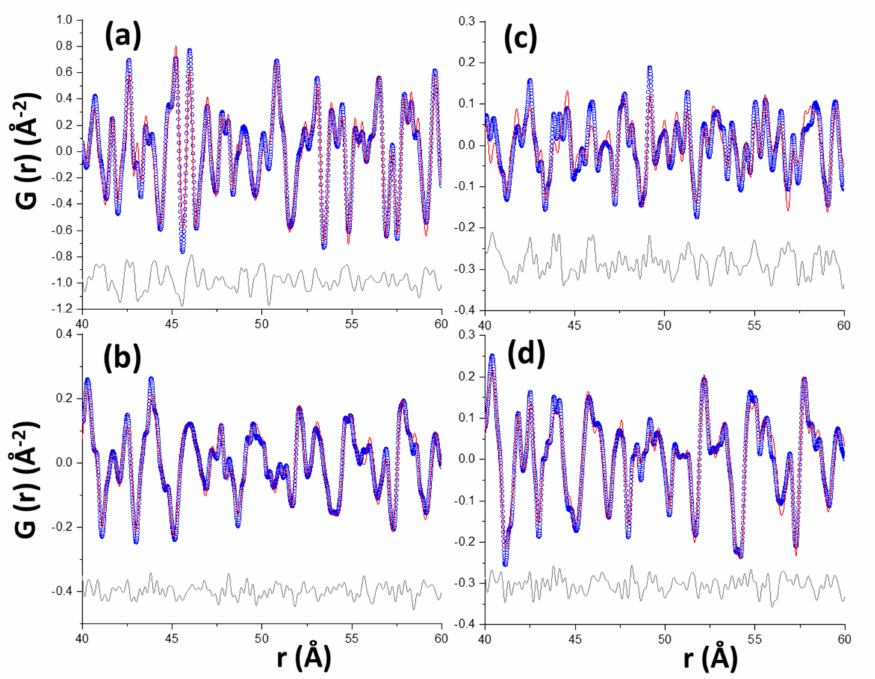
Figure 7. Experimental (blue circles) and fitted (red solid line) large r-range PDF patterns for ( a ) C 3 S_hyd, ( b ) C 3 S_carb, ( c ) C 2 S_hyd and ( d ) C 2 S_carb. Difference curves are shown as grey lines at the bottom of each